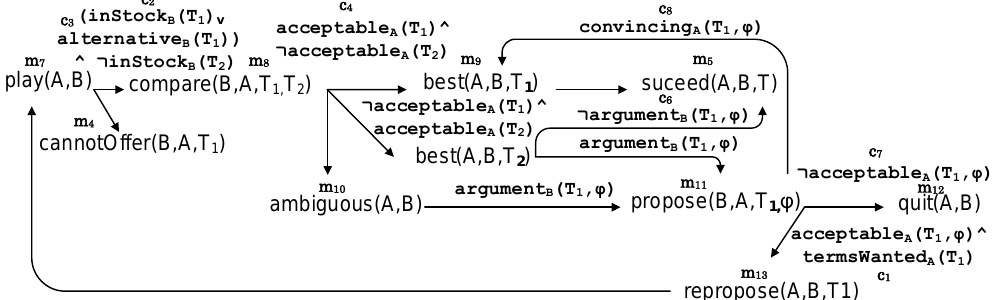
Figure 5. A simple argumentation protocol model for a game online. Additional (redundant) shorthand notation c i / m j is introduced indicating different constraints and messages,